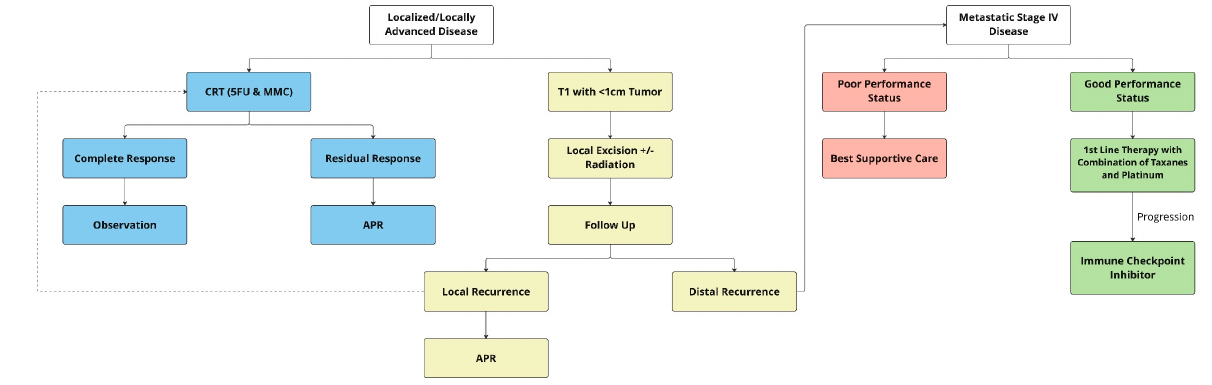
Figure 1. Treatment algorithm of localized and advanced anal cancer. APR = abdominoperineal resection; CRT = chemoradiation therapy